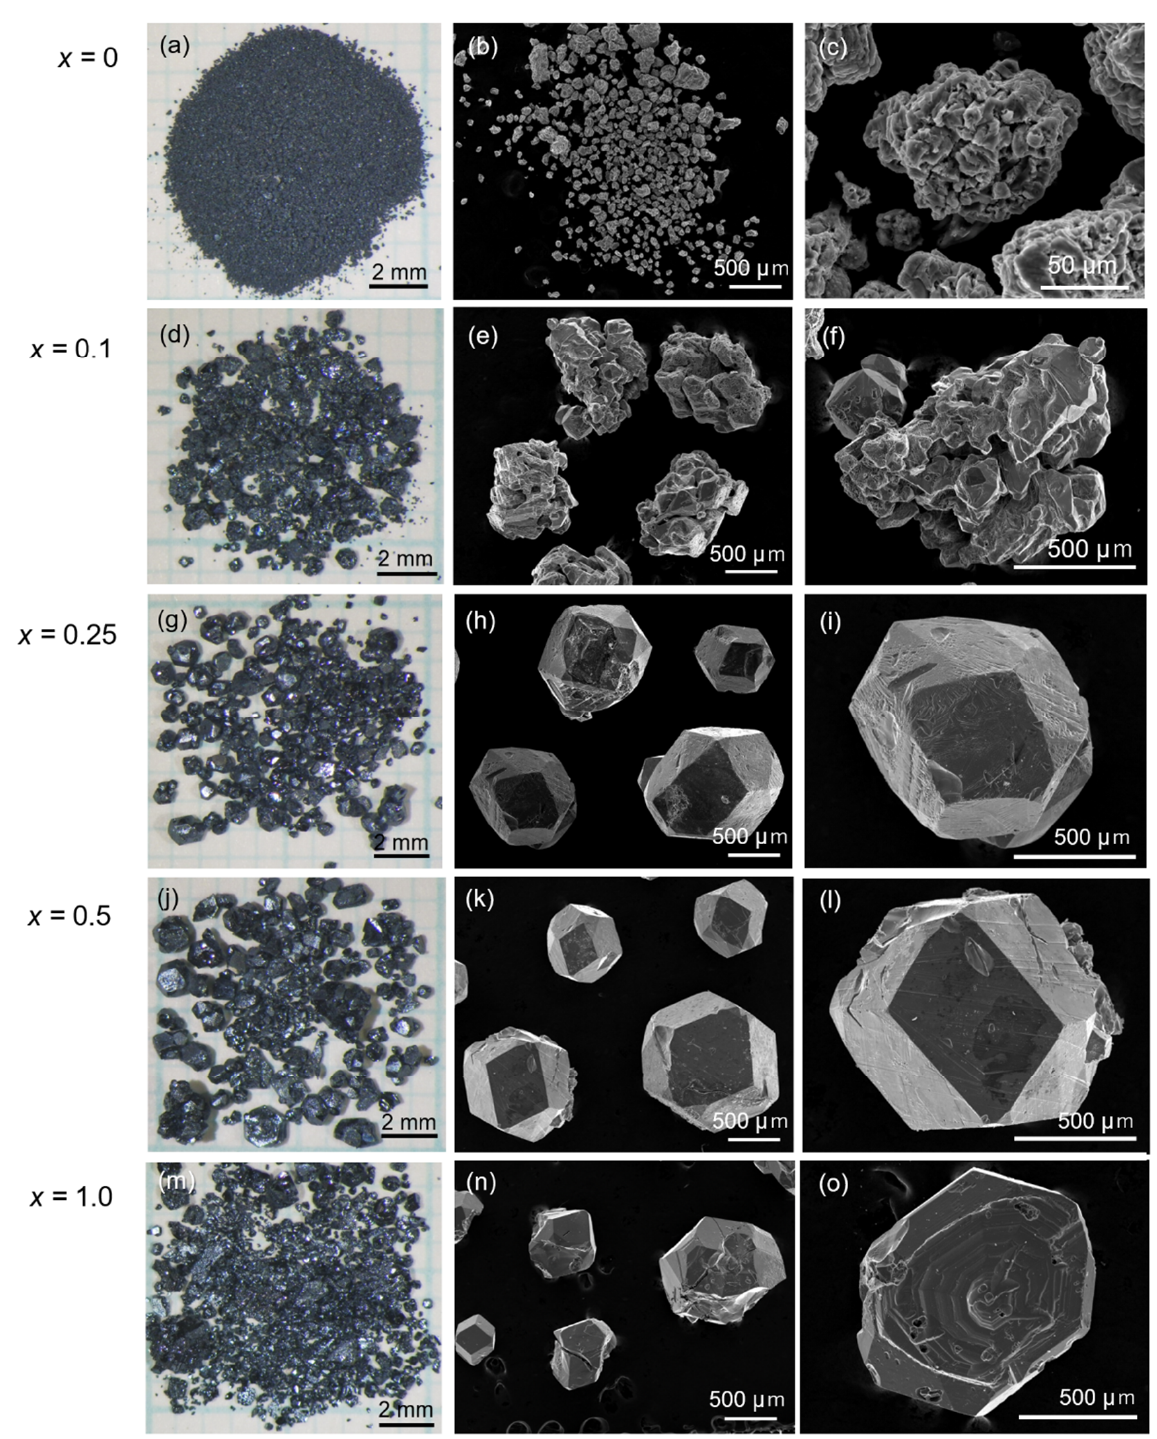
Figure 1. Optical micrographs and SEM images of the samples prepared by heating the Na–Si–Sn solution at 723 K and x values of ( a – c ) 0, ( d – f ) 0.1, ( g – i ) 0.25, ( j – l ) 0.5, and ( m – o ) 1.0. The Na–Sn fluxes were removed by the ethanol and nitric acid treatments.